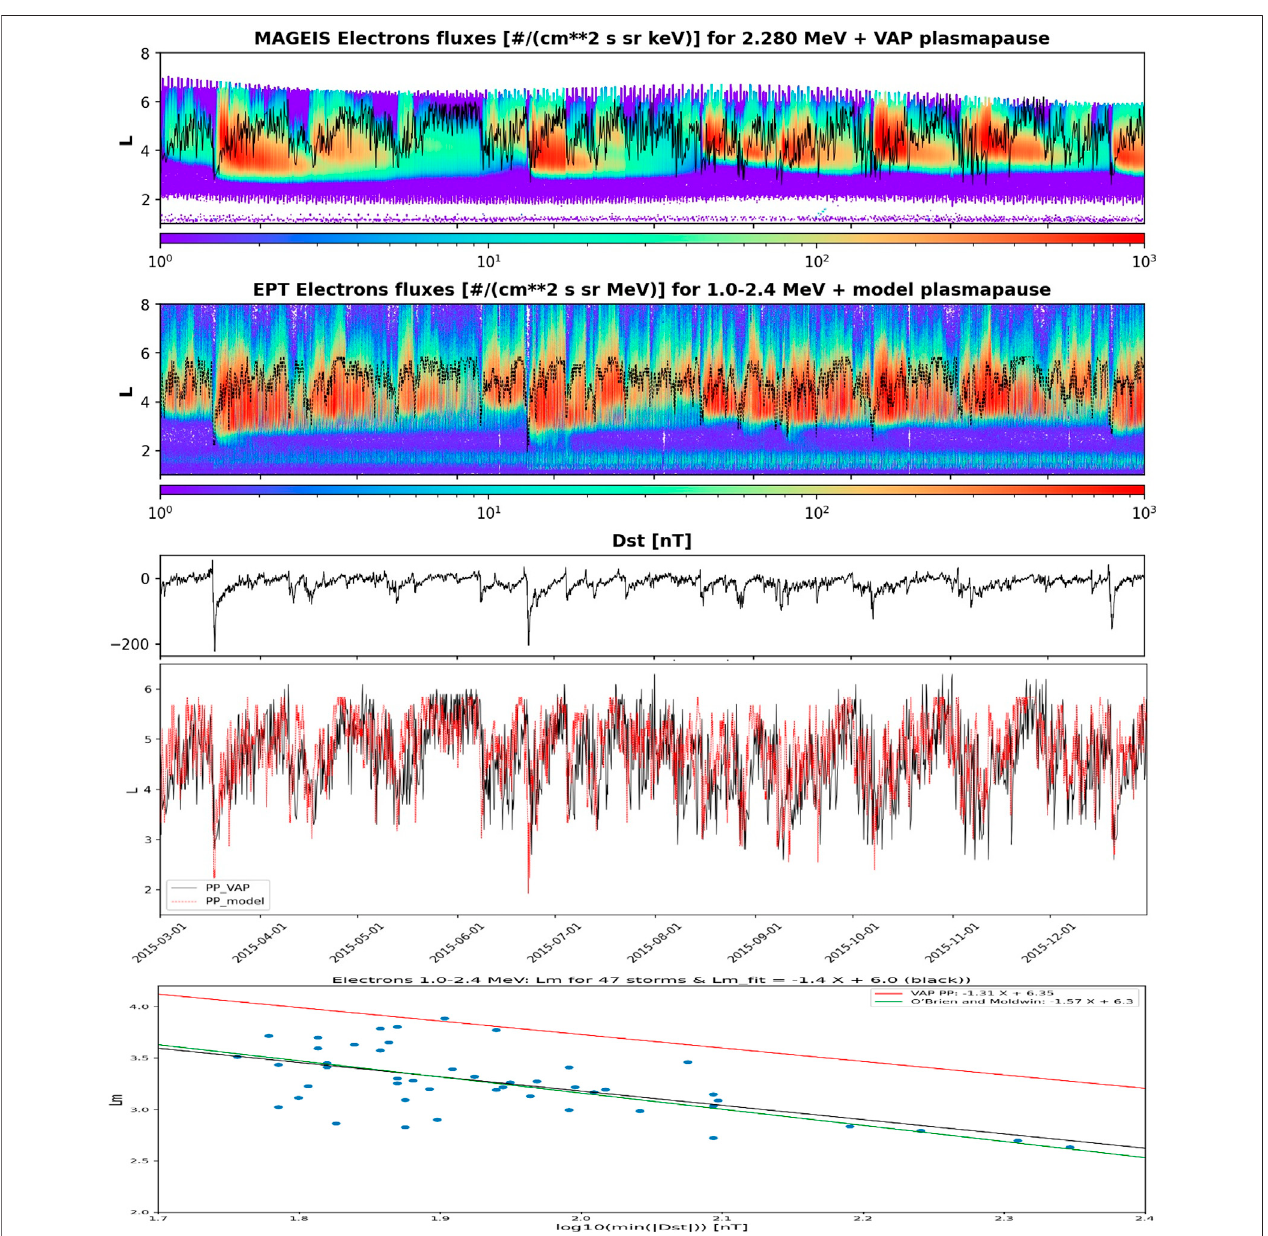
FIGURE 3 | Upper panel: Electron fl ux measured by MagEIS on board the Van Allen Probes at 2.28 MeV from March 1, 2015 to December 31, 2015. The black linecorresponds totheplasmapausecomputed fromspacecraftcharging measured byEFW onboardtheVanAllenProbes. Second panel: Electron fl uxmeasured by PROBA-V/EPT at 1 – 2.4 MeV from March 1, 2015 to December 31, 2015. The black line corresponds to the plasmapause obtained from the SPM model. Third panel: ObservedDstindexfromMarch1,2015toDecember31,2015. Fourthpanel: ComparisonoftheplasmapauseobservedbyVanAllenProbes(blackline)withthe plasmapauseobtainedfromtheSPMmodel(redline)fromMarch1,2015toDecember31,2015. Bottompanel: Bluedots:lowestpositionLmofthe fl uxinjectedinthe slotduringthe47biggeststormsobservedbyPROBA-V/EPTCh5(1 – 2.4 MeV)fromMay2013toDecember2019,asafunctionoflog10|minDst_24 h|.Blackline:best linear fi t function for Lm. Red line: Best fi t of plasmapause position as a function of log10|min Dst_24 h| as observed by Van Allen Probes ( Eq. 1 ). Green line: Best fi t of plasmapause position as observed with CRRES ( Eq. 5 ).